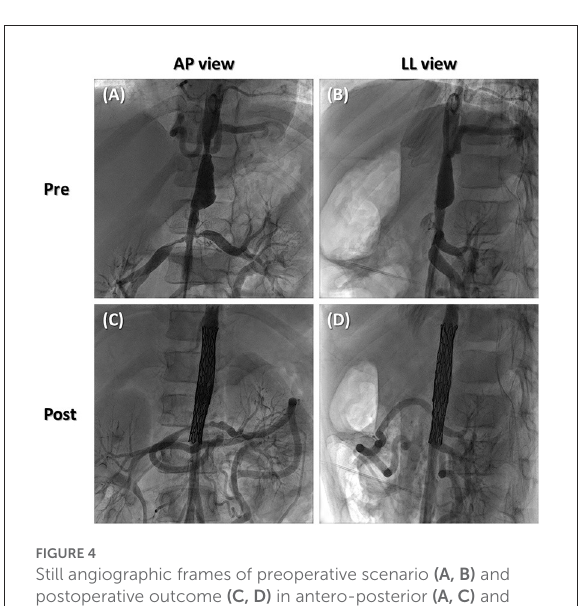
FIGURE4 Still angiographic frames of preoperative scenario (A, B) and postoperative outcome (C, D) in antero-posterior (A, C) and latero-lateral views (B, D)